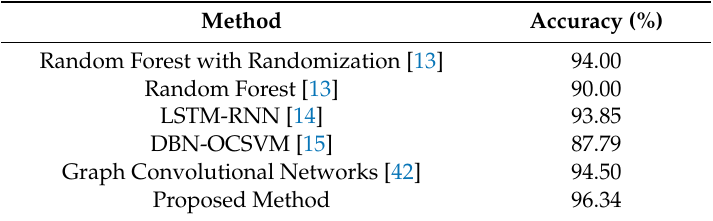
Table 7. Performance comparison with existing approaches using the CMU CERT dataset